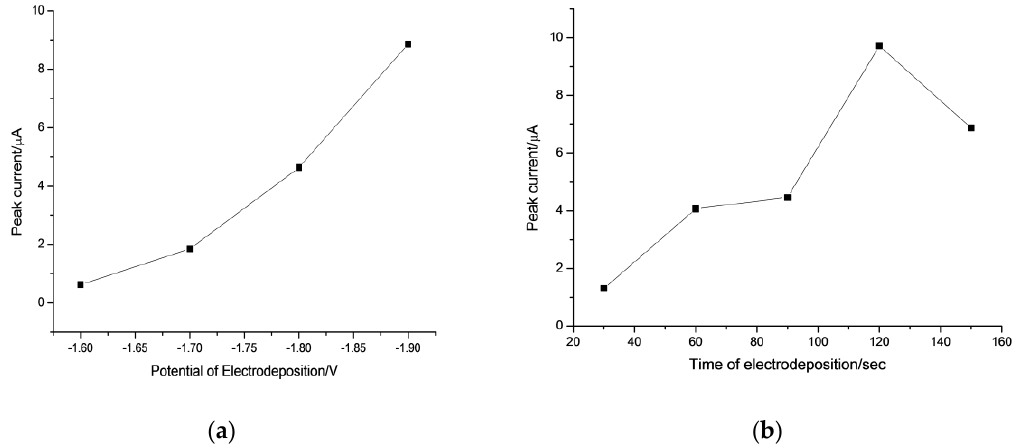
Figure 3. Effect of deposition potential ( a ) and deposition time ( b ) upon the SW-ASV response of 1 ng L − 1 Al(III) after LPME on a GDE. In ( a ) deposition for 120 s; in ( b ) deposition at − 1.8 V. LPME conditions: centrifugation rotor speed, 4500 rpm; extraction time, 10 min; pH of the sample, 6.5; sample volume, 30 mL; concentration of oxine, 0.67 mmol L − 1 ; extraction IL, 150 µ L. SW-ASV, quiet time: 10.0 s; frequency: 20.0 Hz; pulse amplitude: 25.0 mV; scan increment: 4.0 mV. All measurements were made in triplicate and the results were averaged.